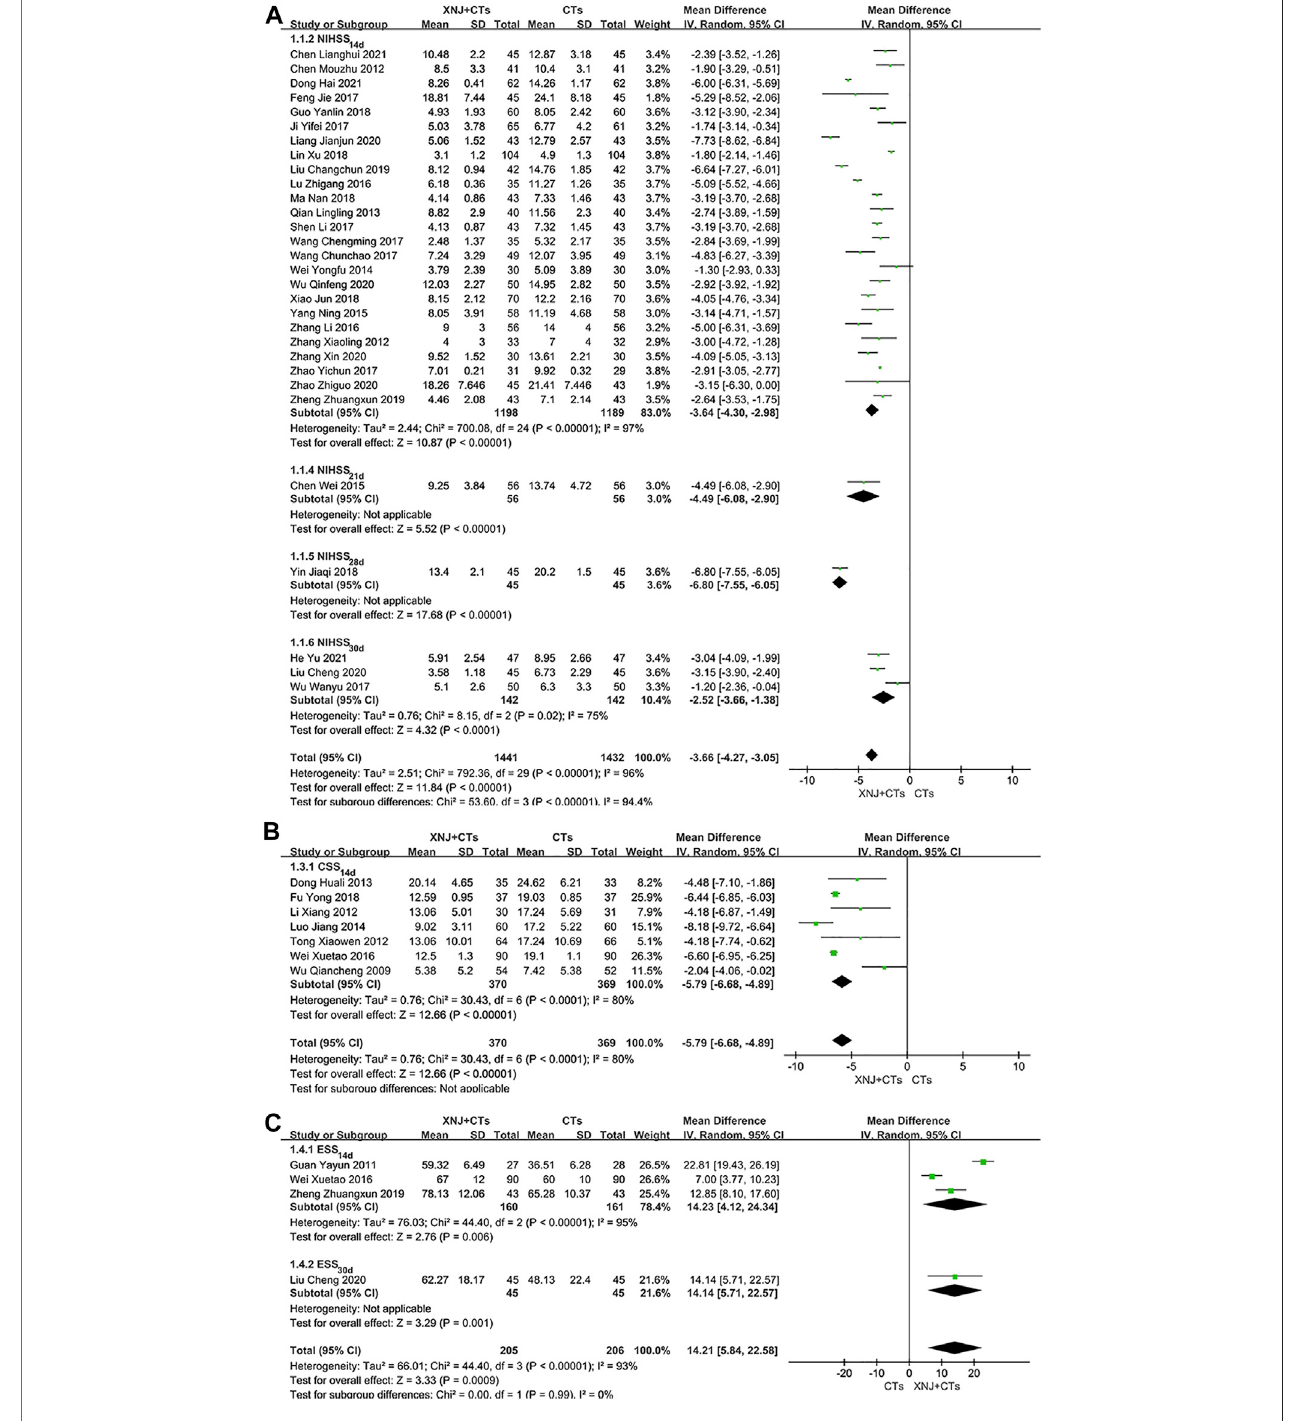
FIGURE 4 | Forest plot of NIHSS (A) , CSS (B), and ESS (C) .